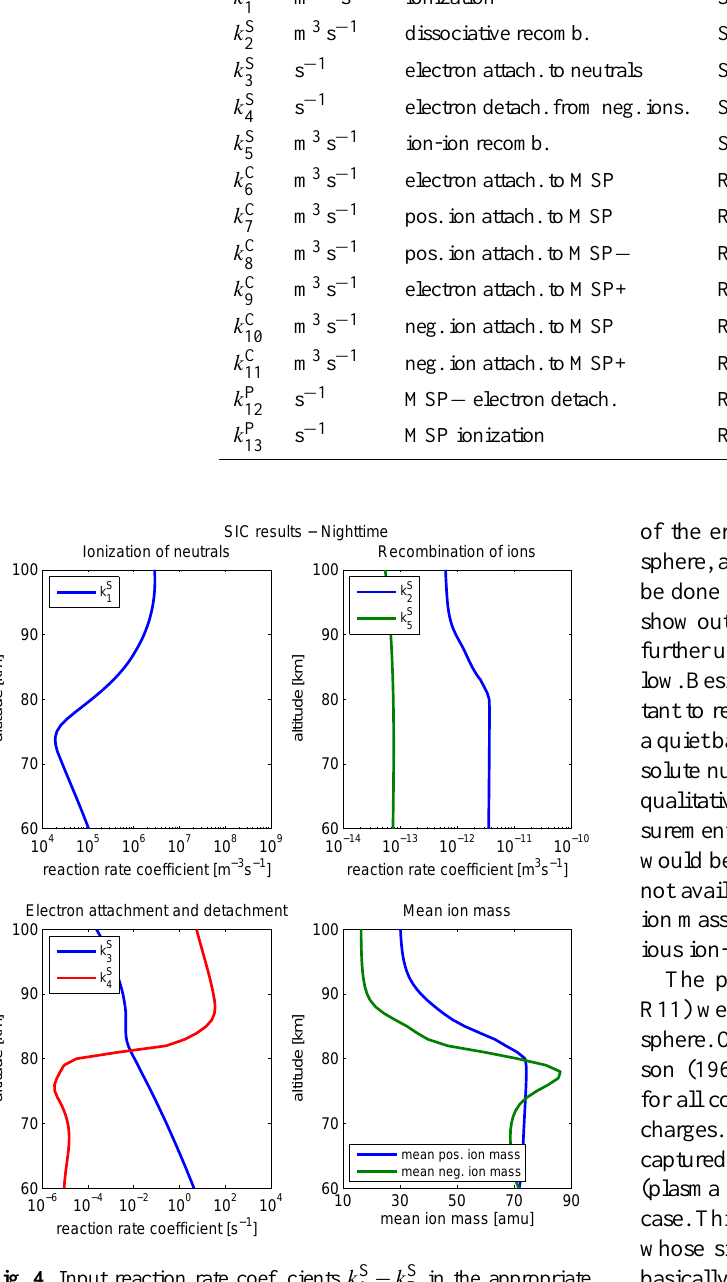
Fig. 4. Input reaction rate coefficients k S form for the use in the described model (see Table 2 for details), note k S is the absolute ionization rate due to solar radiation and 1 galactic cosmic rays; also shown is the mean ion mass, from SIC model results, for the 8th September 2010, 23:55 LT, 69 ◦ N, 16 ◦